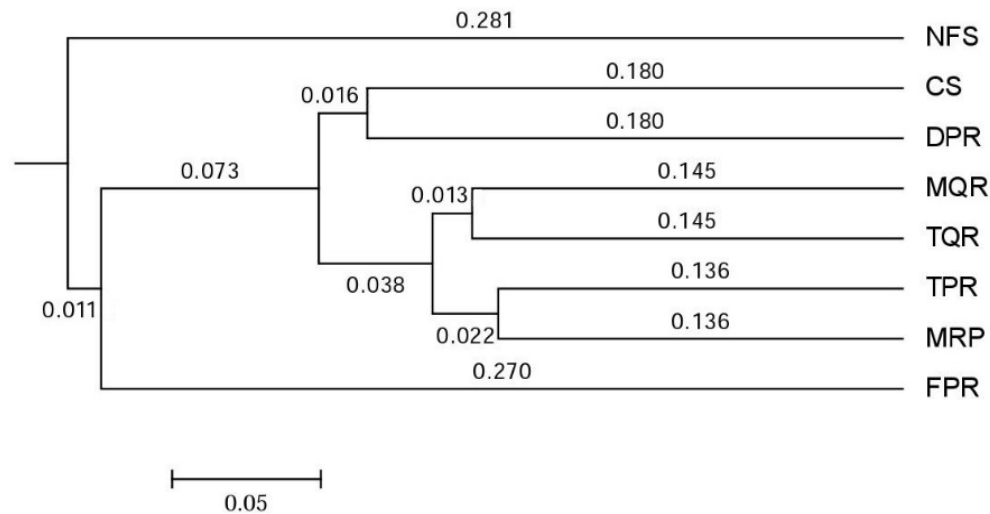
Figure 3. Hierarchical clustering of soil bacterial communities according to the Bray-Curtis similarity algorithm and unweighted pair group with arithmetic mean. CS, control soil; MPR, middle portion of Pinus tabuliformis roots; TPR, tips of P. tabuliformis roots; MQR, middle portion of Quercus variabilis roots; tips of Q. variabilis roots; FPR, post-fire planted forest of P. tabuliformis ; DPR, dead P. tabuliformis roots; NFS, natural P. tabuliformis forest.